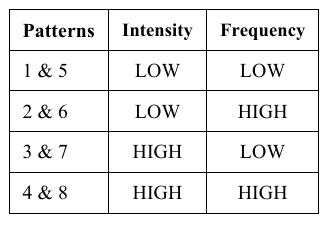
I NTENSITY R ANGE AND F REQUENCY OF THE V IBRATIONS Intensity in Pulse Width Modulation (PWM)